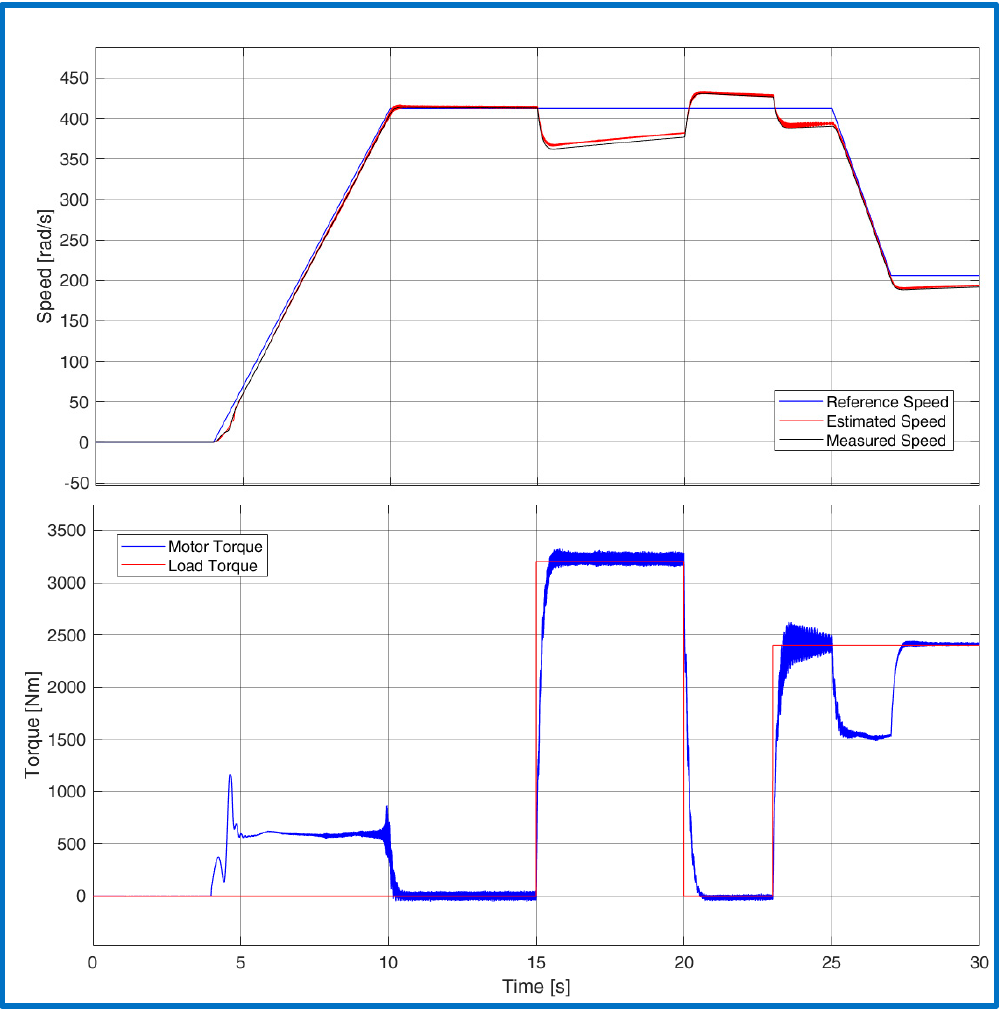
Figure 21. Reference (blue), estimated (red), and measured speed (black), with inverter and continuous cable model (up), motor torque (blue), and load torque (red), with inverter and continuous cable model (down).